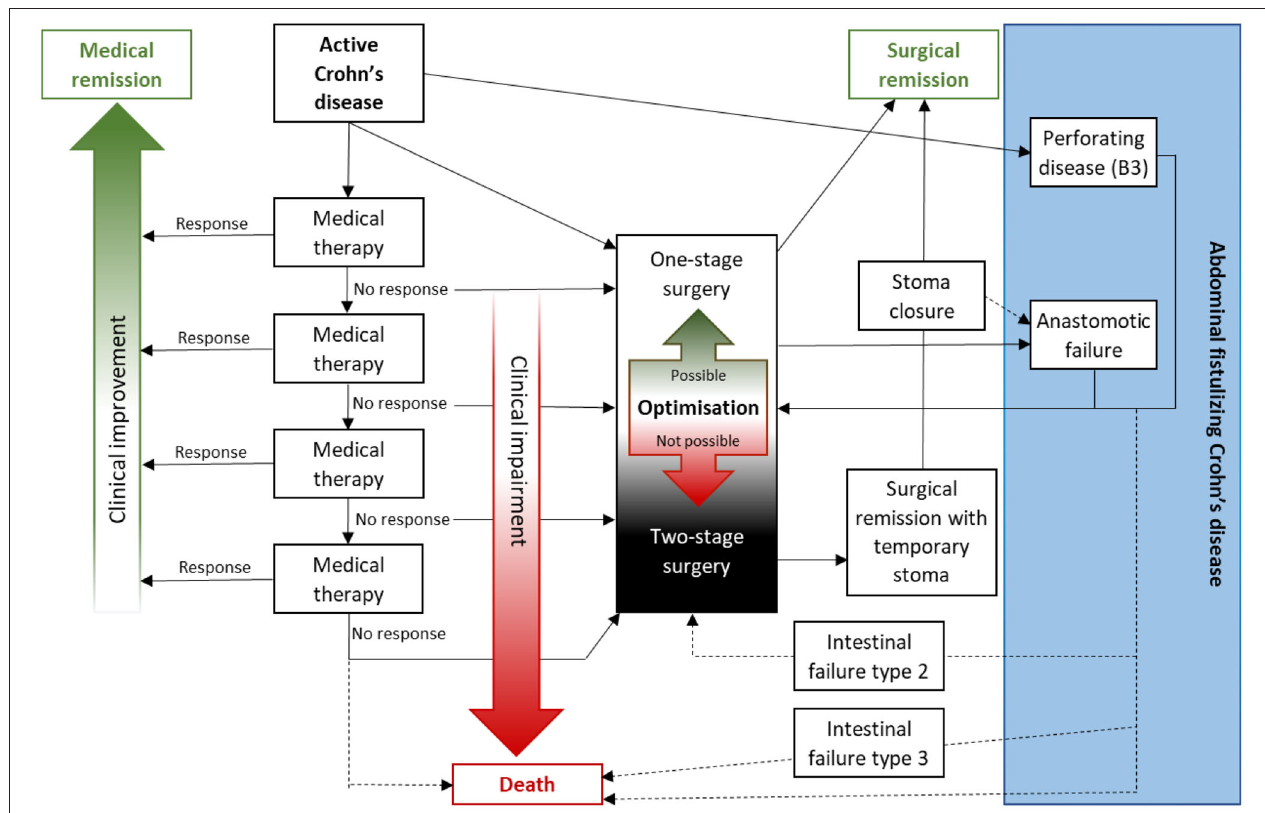
FIGURE 1 | Abdominal fistulizing Crohn’s disease may develop due to penetrating disease but more often due to surgical complications. With increasing non-responsive attempts with medical therapies (e.g., steroids, immunomodulators, and/or biologicals) patients may develop clinical impairment with an increasing number of surgical risk factors like weight loss, hypo-albuminemia, or penetrating disease. Before deciding on a primary anastomosis or not the risk of anastomotic dehiscence should be evaluated as well as if the patient is fit enough to survive such complication or not. The patient must be fully aware of such risks as there is a risk of severe post-operative morbidity and mortality. In a patient deemed not suitable for surgery with primary anastomosis pre-operative optimization (e.g., enteral or parenteral nutrition, drainage of collections, and antibiotics) may change this and otherwise patients should be advised toward two-stage surgery with two-barrel stoma (of the future anastomosis) or possibly a covering